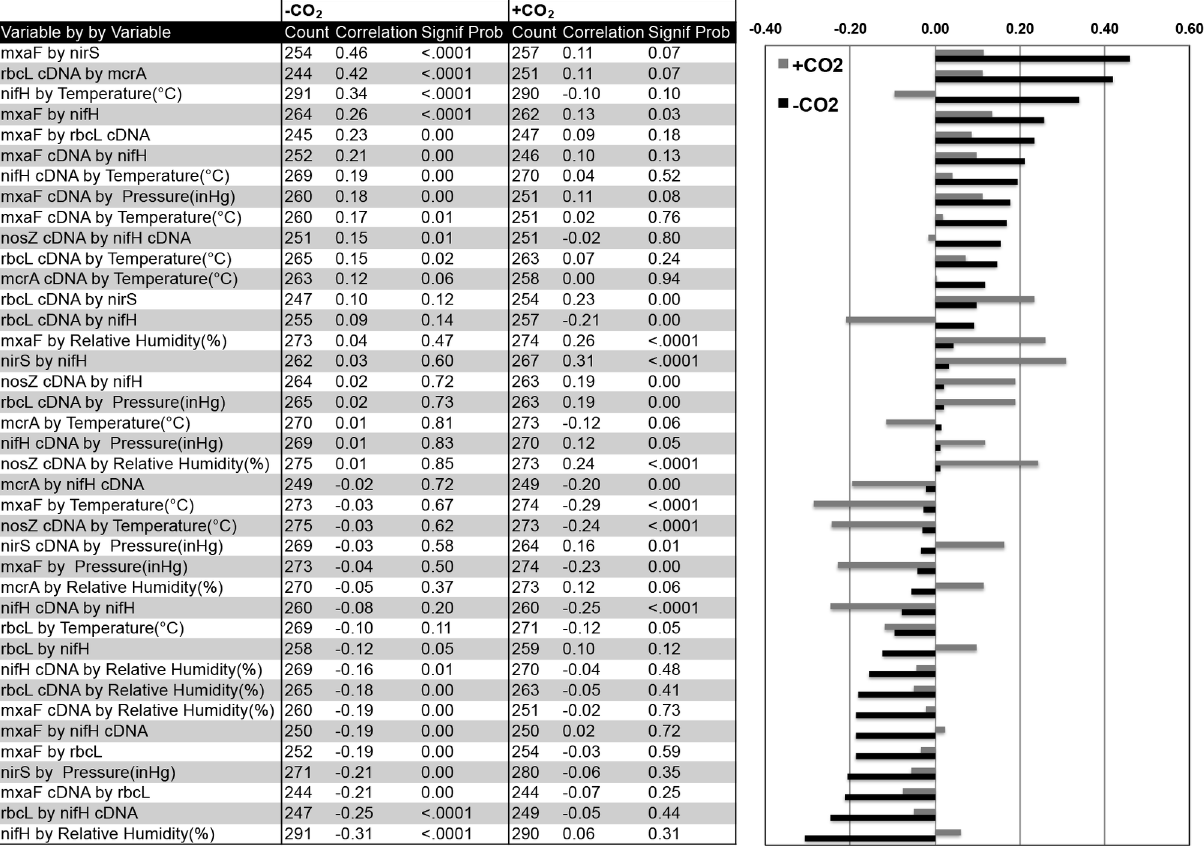
. All data points for all variables 2 exposed samples. Only variables displaying shifts in correlations in 2